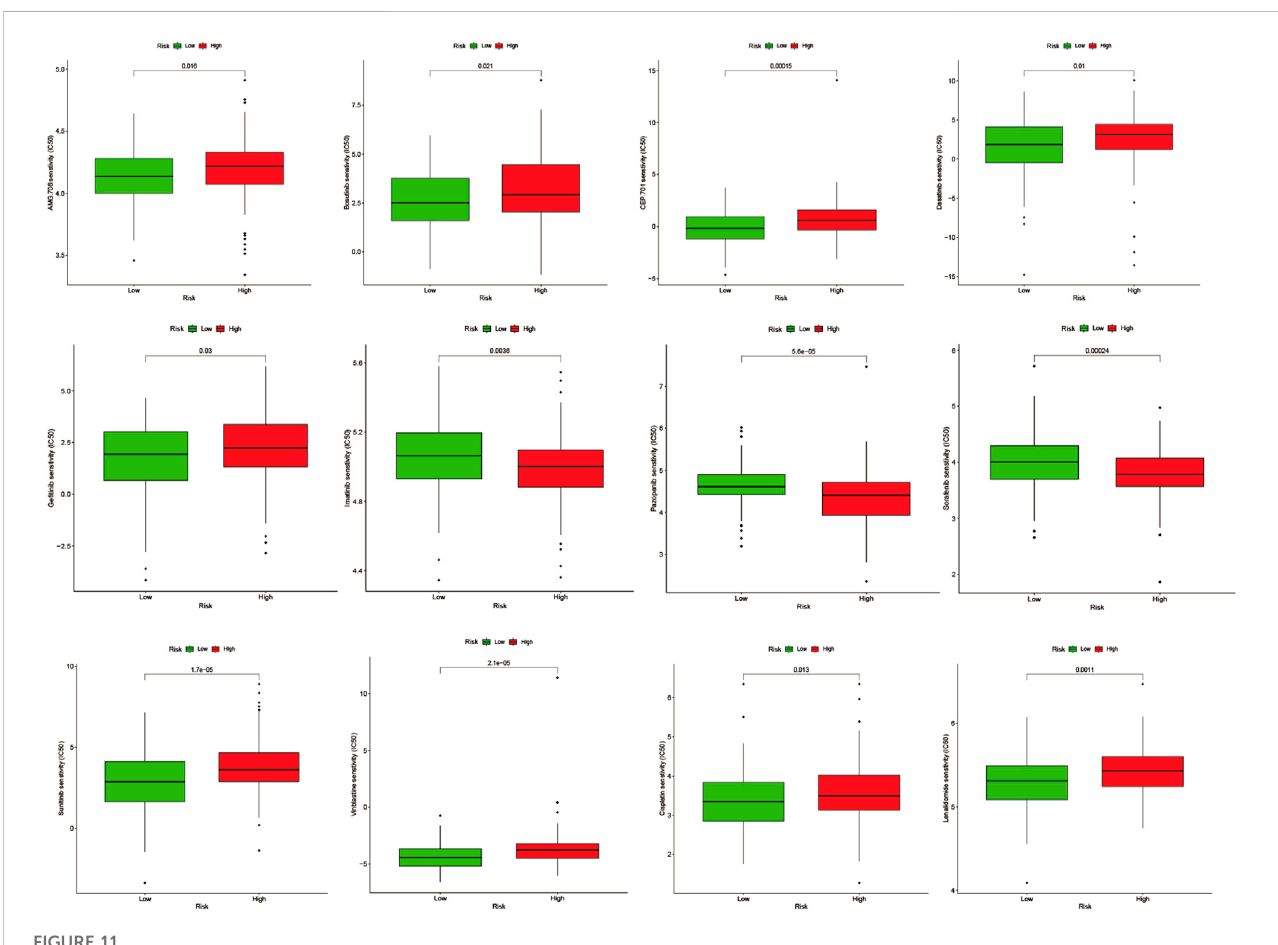
FIGURE 11 Drug sensitivity analysis in the high and low AGS